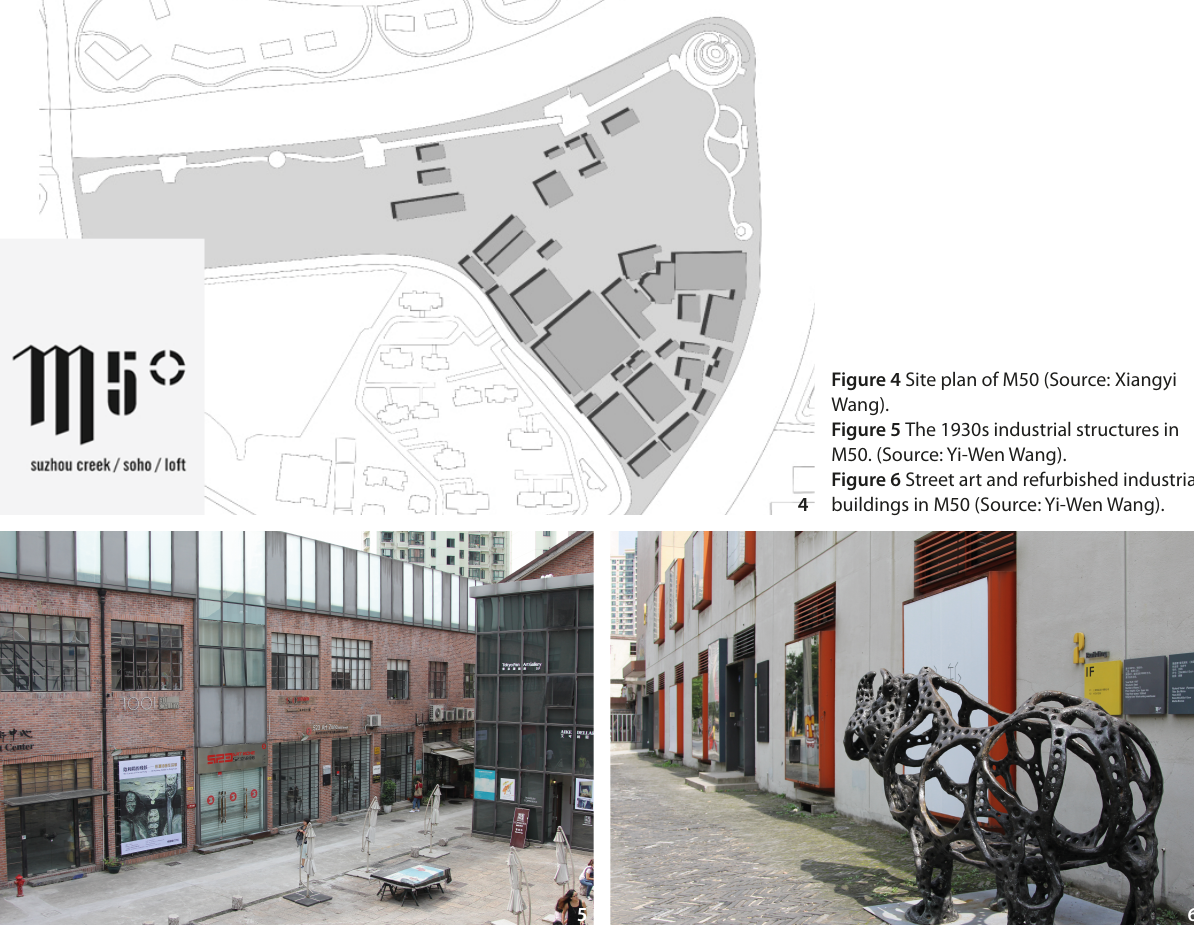
Figure 4 Site plan of M50 (Source: Xiangyi Wang). Figure 5 The 1930s industrial structures in M50. (Source: Yi-Wen Wang). Figure 6 Street art and refurbished industrial buildings in M50 (Source: Yi-Wen